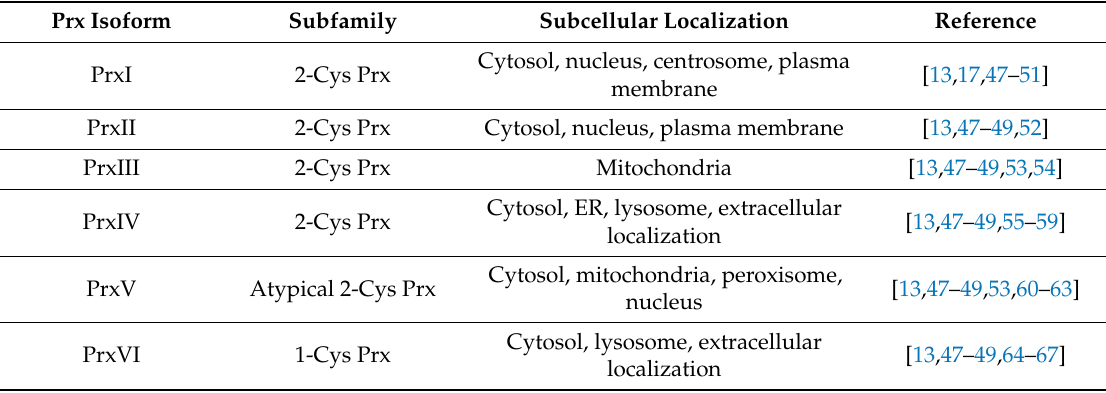
Table 1. Subcellular localization of peroxiredoxin isoforms inside and outside of the